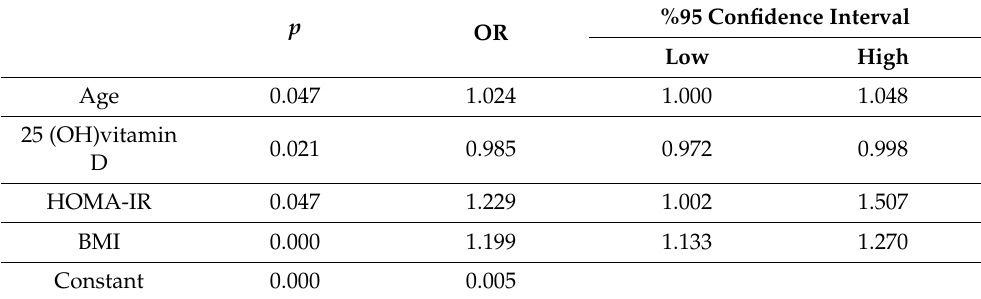
Table 2. The multivariate logistic regression model. p OR %95 Confidence Interval Low High